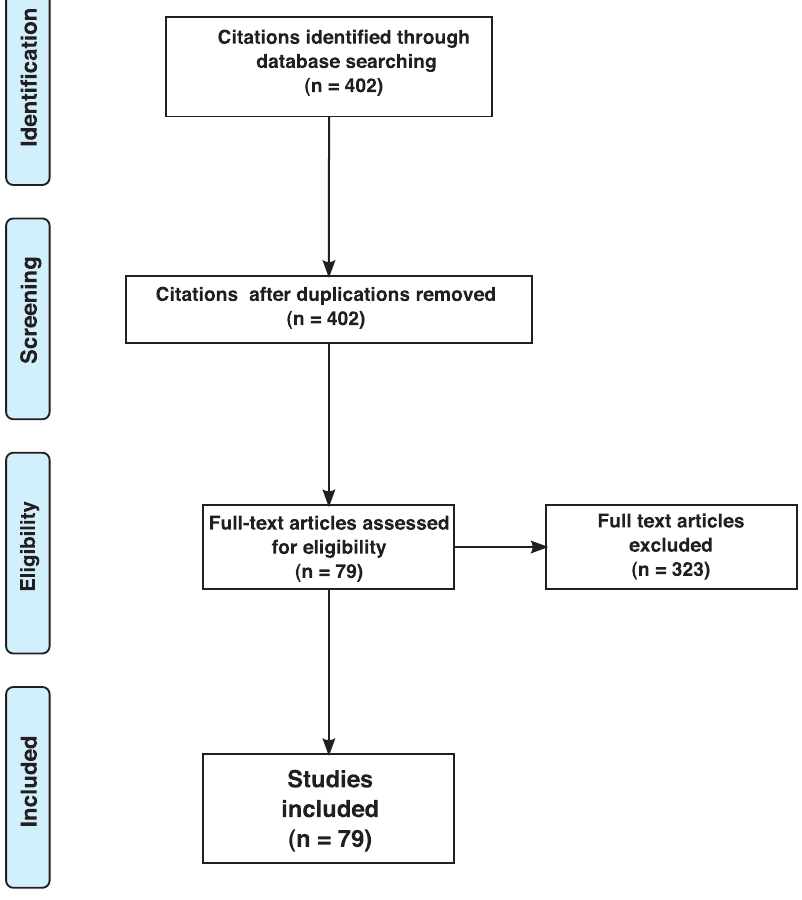
Figure 4. Flowchart for study selection.